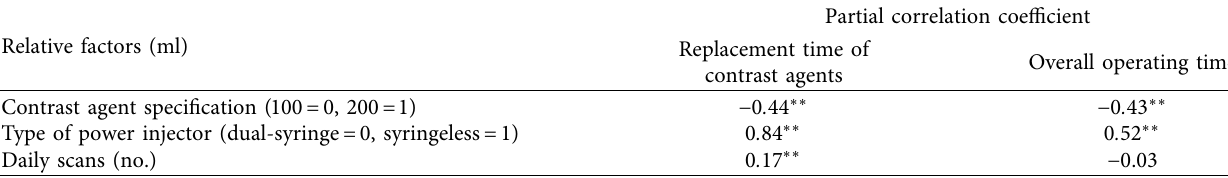
Partial correlation coefcient Replacement time of Overall operating time contrast agents